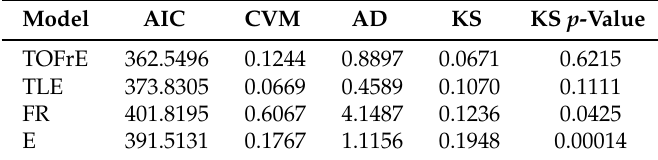
Table 10. Numerical measures of fitness of the models for Data set I.